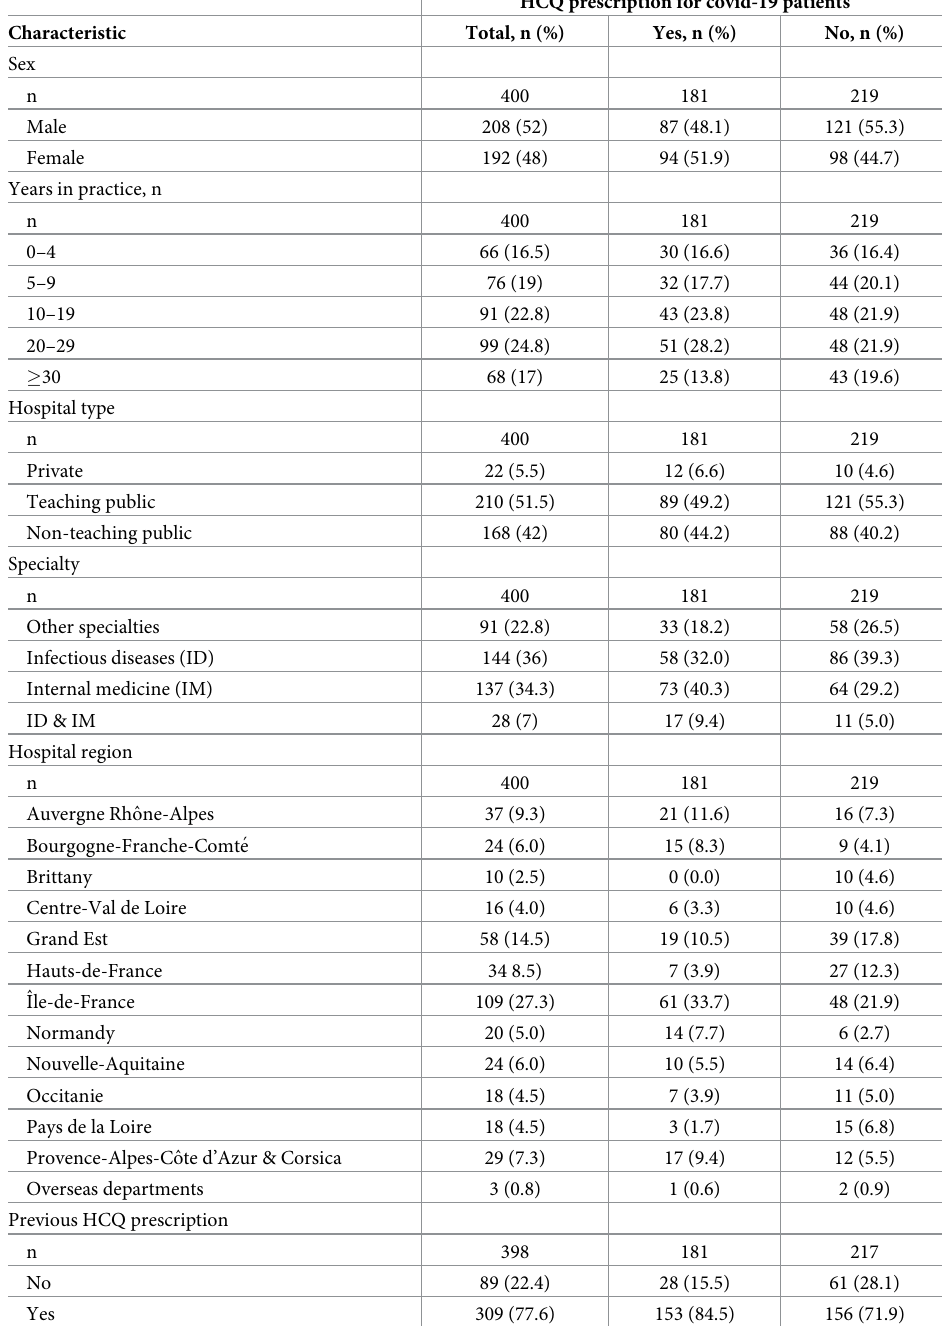
Table 1. Participating hospitalists’